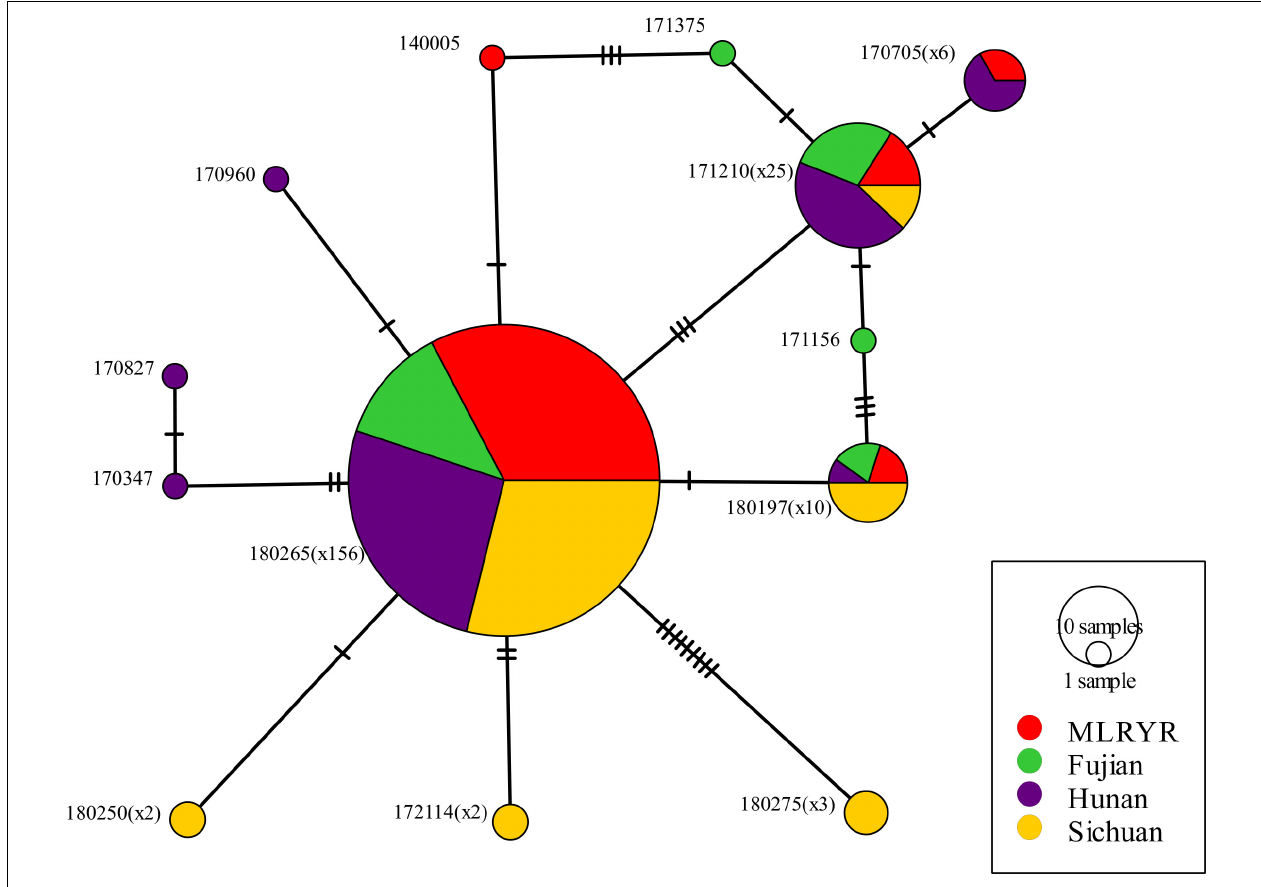
FIGURE 4 | Minimum spanning network inferred from non-intronic regions from 210 F. asiaticum isolates. Each perpendicular black line indicates an individual SNP. The number of each haplotype is reflected by size of each circle and by the exact number is given in parentheses following the haplotype codes, except for those haplotypes representing only single